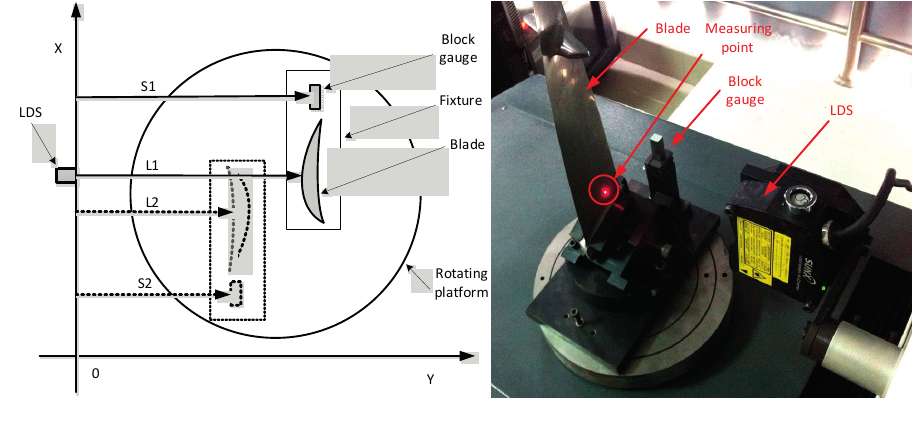
Figure 11. Measurement path planning